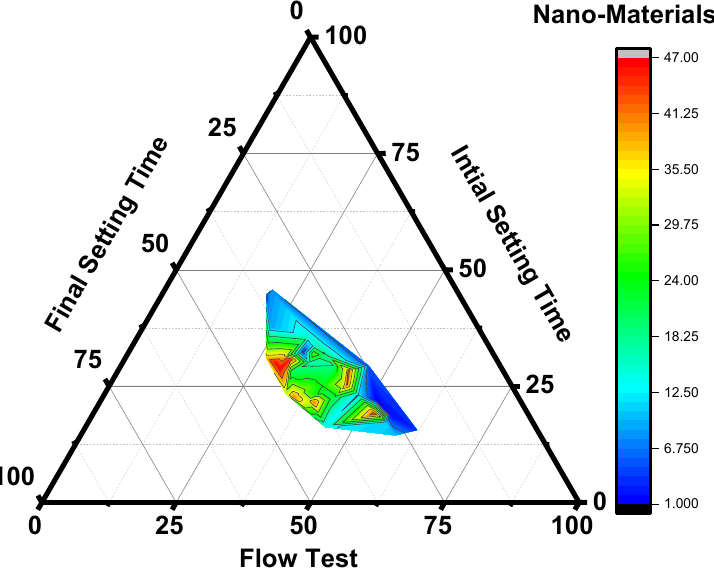
Figure 4. Ternary plot for flow test (mm) and setting time